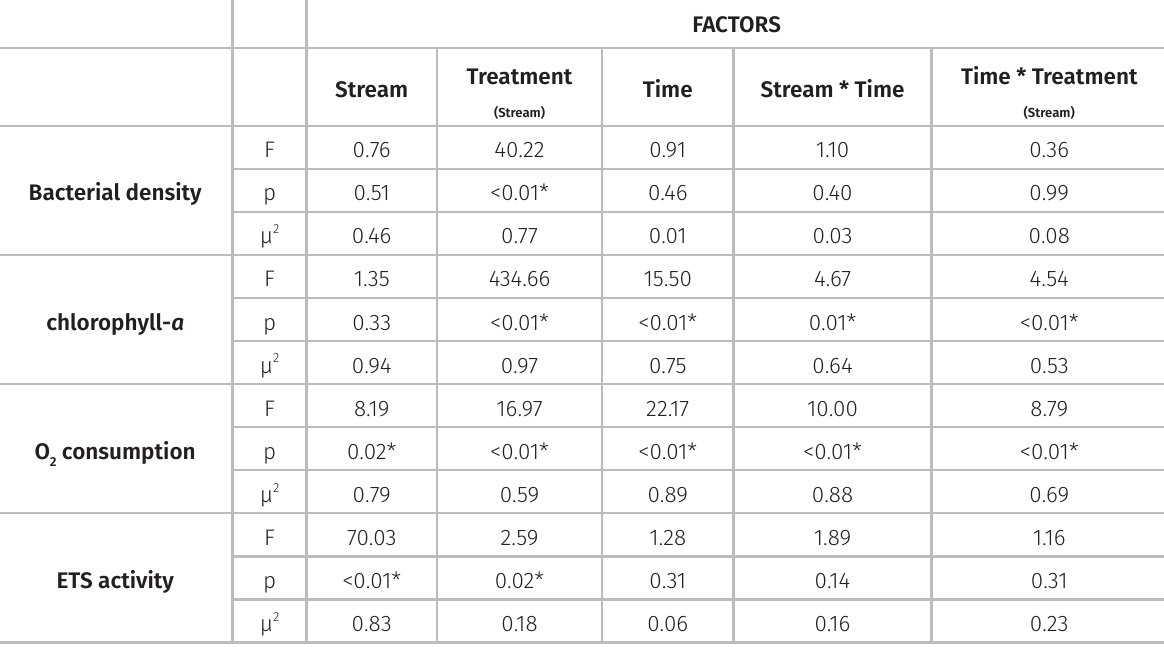
Table II. Nested ANOVA results for the biological variables considering Streams, Treatment Time. Significant results (p-value < 0.05) are marked with * and µ 2 is provided as a measure of effect